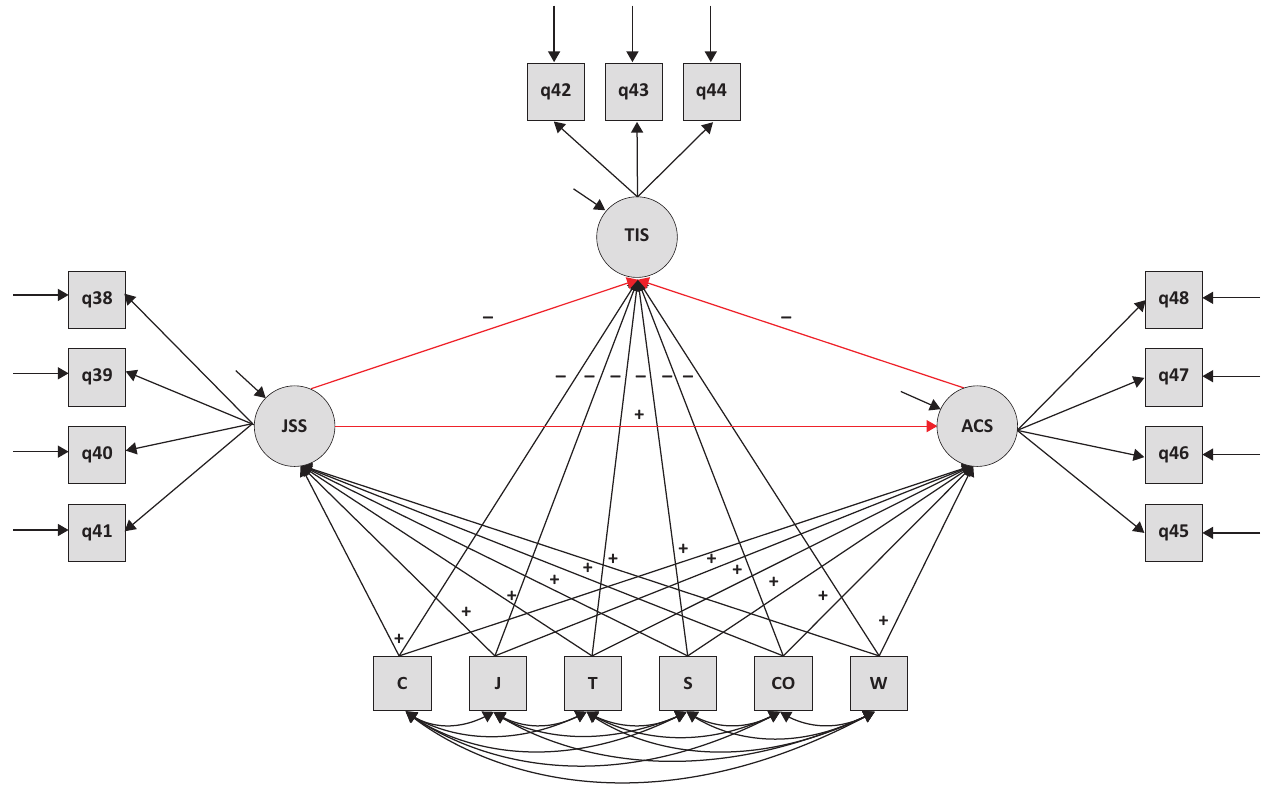
FIGURE 1: The restricted exploratory within confirmatory (EwC) structural equation measurement model tested for the Retention Factor